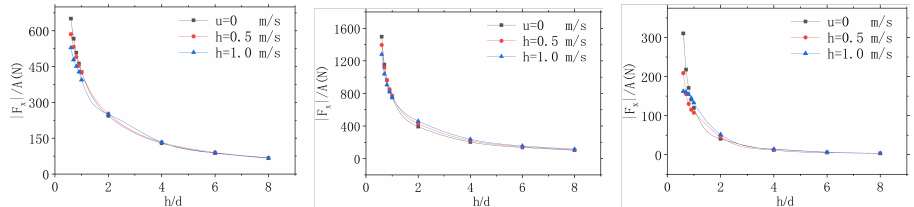
Figure 15. From left to right: maximum longitudinal force, vertical force, and pitch moment at different submerged depths.